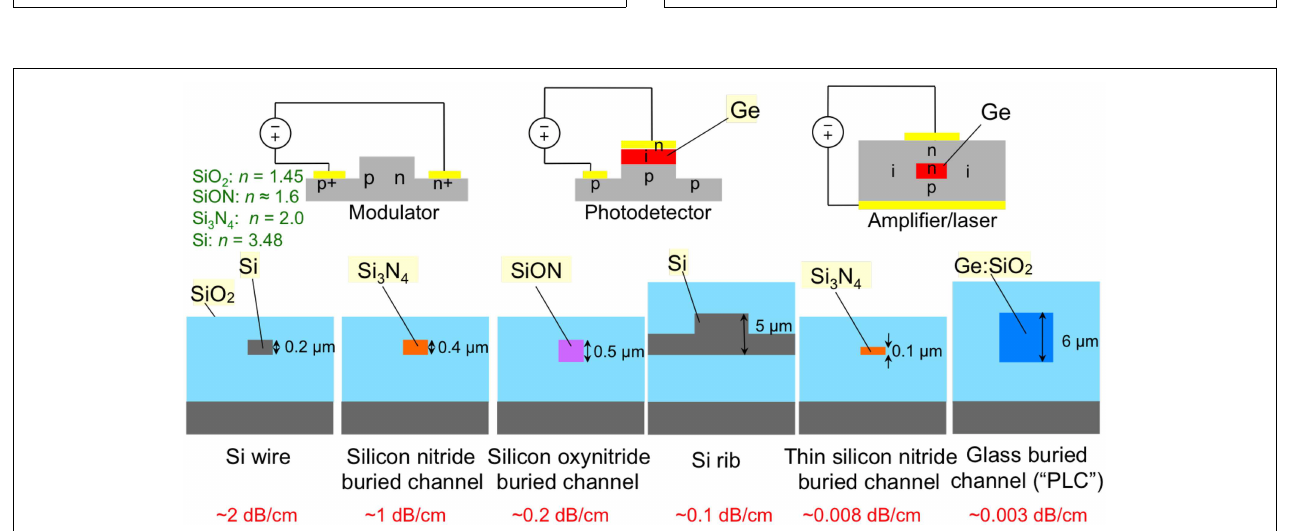
FIGURE 6 | Cross sections of the family of Si-based optical waveguides. Also shown are typical propagation losses and refractive indices.